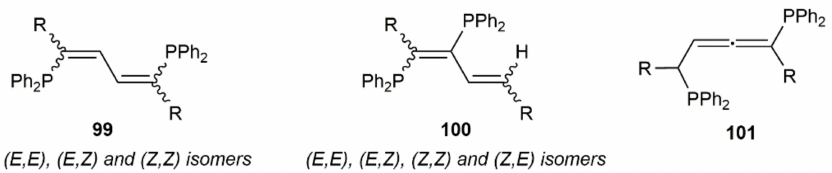
Figure 13. Products formed in the [Ca(THF) 4 (PPh 2 ) 2 ]-catalyzed hydrophosphination of